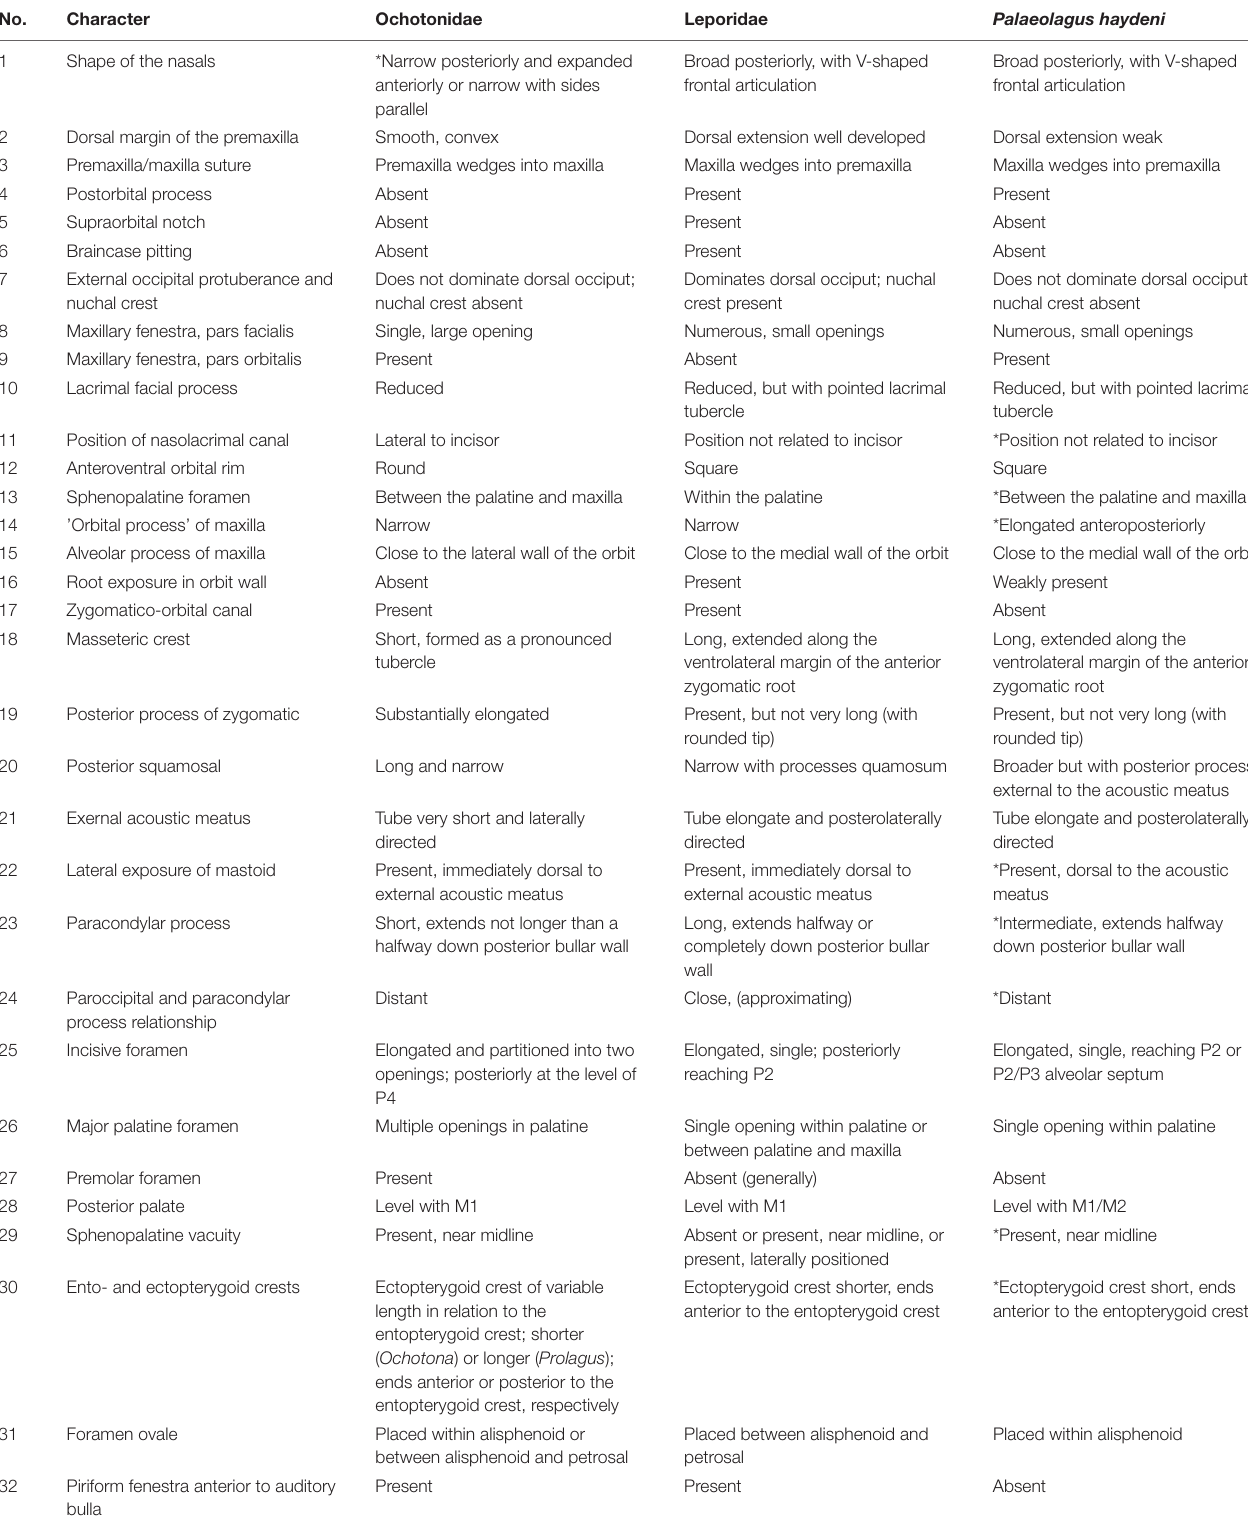
TABLE 1 | Comparison of cranial character states based mostly on the character-taxon matrix of Wible (2007), between Ochotonidae (represented by Ochotona and Prolagus ), Leporidae [represented by sample studied by Wible (2007) and the comparative material for the present study], and Palaeolagus haydeni .